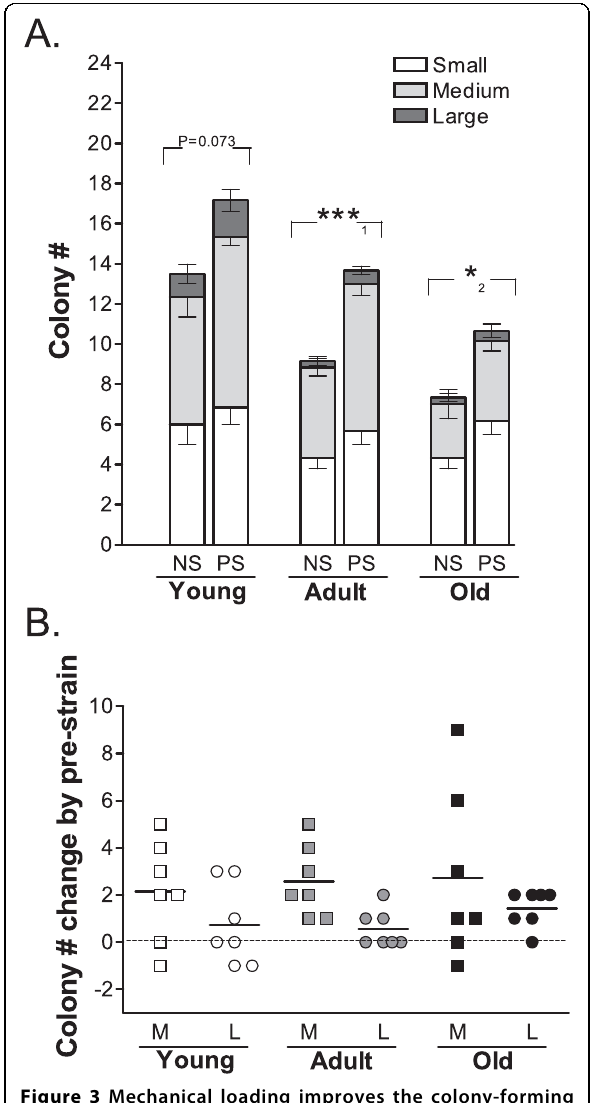
Figure 3 Mechanical loading improves the colony-forming ability of young, adult, and old ADSCs . A . Number of colonies after 5 day culture of ADSCs, which were pre-exposed to mechanical strain (PS) or as non-strain controls (NS). Colony size was defined as in Figure 1. *** 1 : P < 0.001, * 2 : P < 0.03. N = 6. B . Increased numbers of medium (M) and large colonies (L) due to pre-exposure to mechanical strain in 8-day ADSC cultures. Each point represents the average of triplicate measurements of ADSCs from one mouse. N =